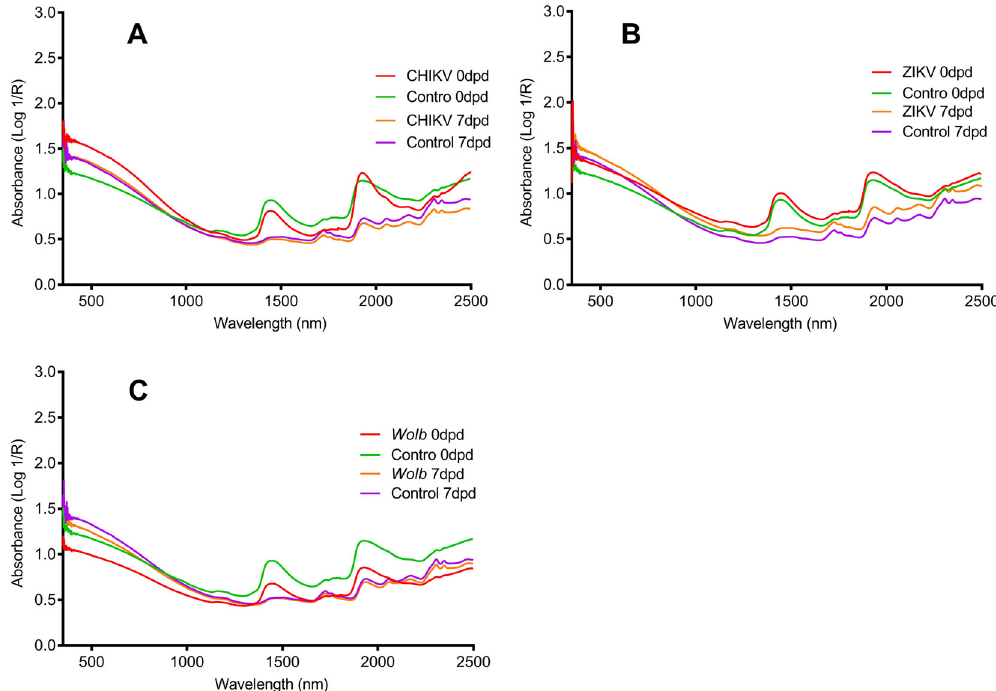
Fig. 2 Changes in raw spectra of A. aegypti mosquitoes. CHIKV-infected and uninfected mosquitoes at day 0 and day 7 post death ( a ), ZIKV-infected and uninfected mosquitoes at day 0 and day 7 post death ( b ), and Wolbachia -infected and uninfected mosquitoes at day 0 and day 7 post death ( c ).